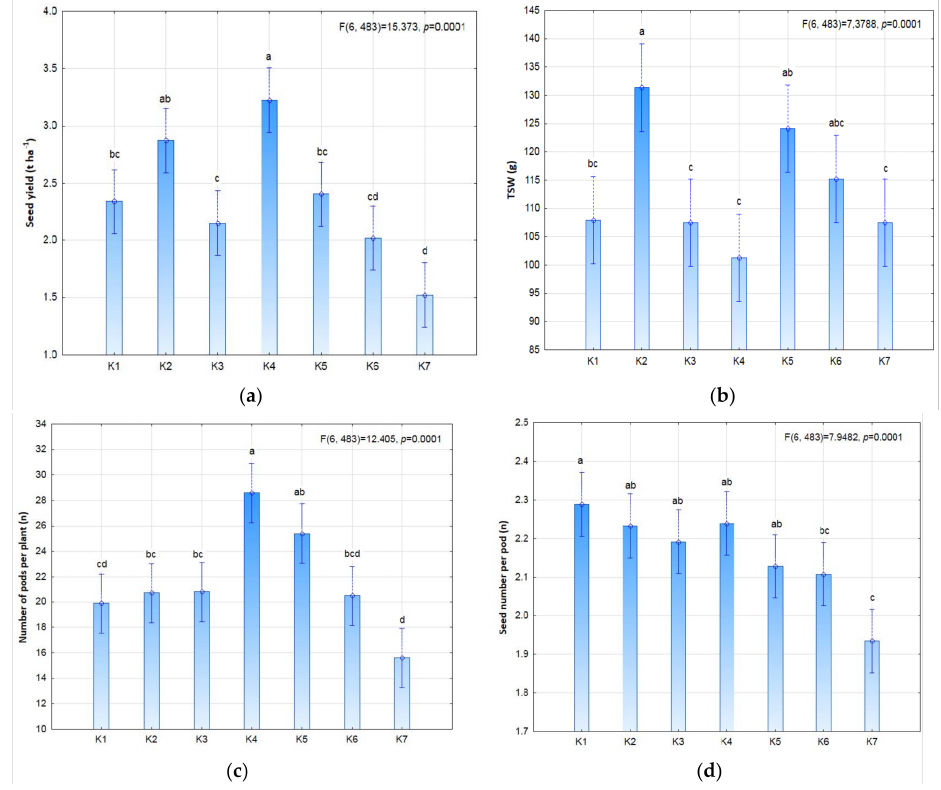
Figure 4. Seed yield ( a ), and yield parameters ( b ) TSW; ( c ) number of pods per plant; ( d ) seed number per pod) of soybean depending on photostimulation treatment. Different letters indicate significant differences between means. Significant effects at p < 0.05.